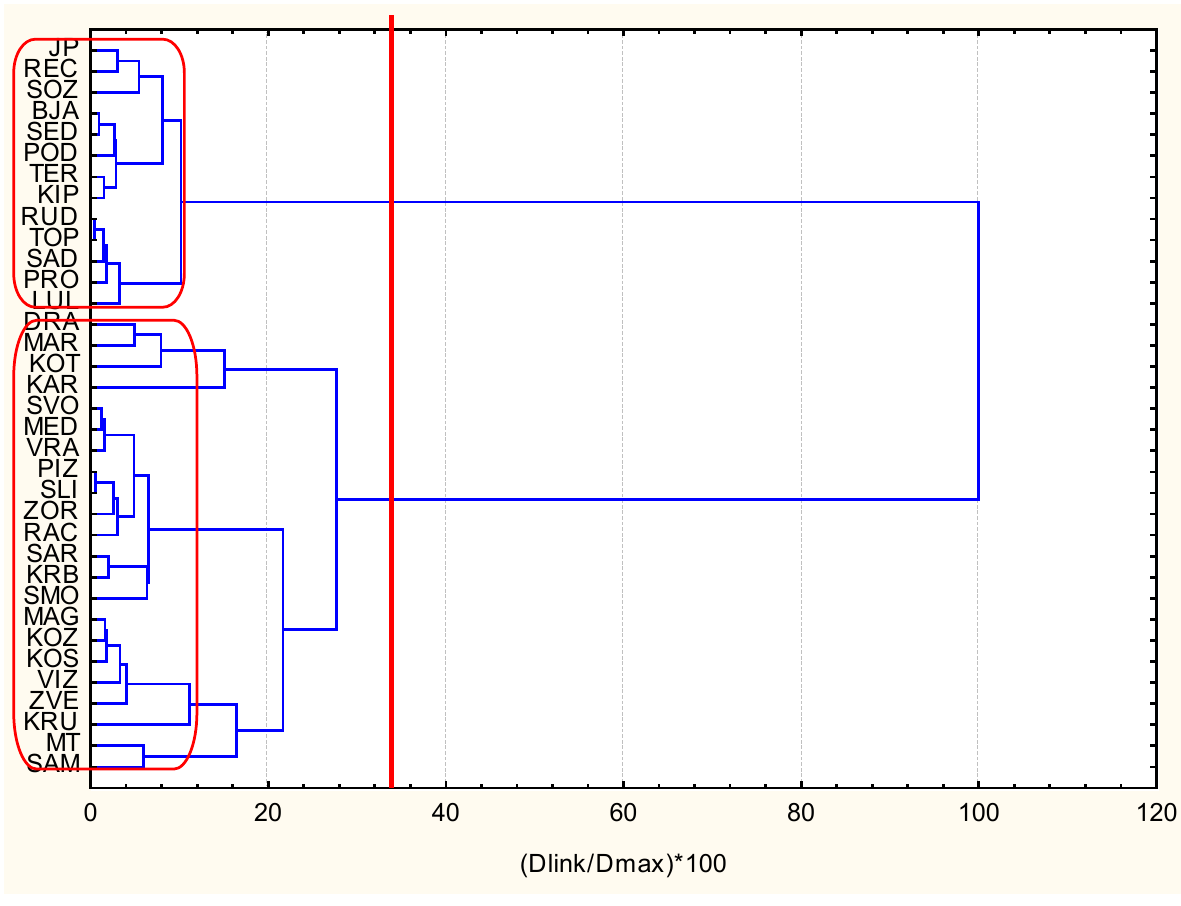
Figure 3: Tree diagram for 35 sampling